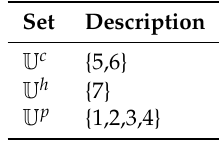
Table A5. Sets used test instance 3.